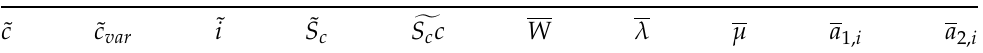
Table A1. Tabulated properties in the turbulent databases. For the adiabatic database ˜ i equals